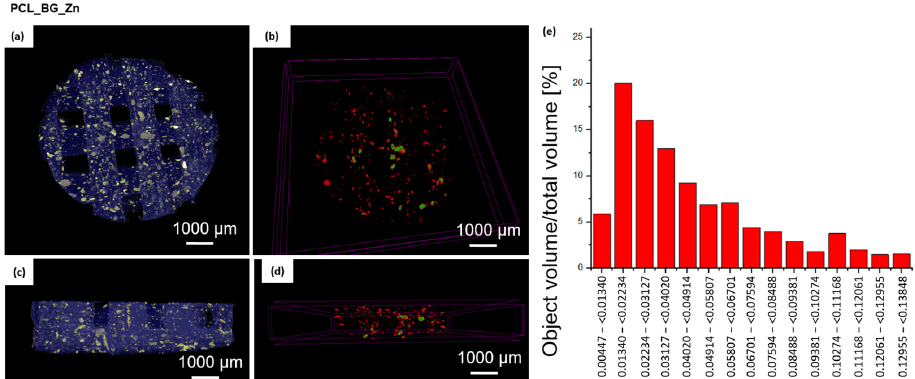
Figure 7. µCT images of sample PCL_BG_Zn before incubation in SBF. Images showing the top view ( a ) and the cross-section of the scaffold ( c ). The scaffold volume is marked in blue; the distribution of the modifying particles is highlighted in yellow. Distribution of BG_Zn particles without the pol- ymer matrix ( b , d ) (particles marked in red and green). Histogram of the distribution of particles ( e ). In the sample PCL_BG_Zn before incubation (Figure 7), 1596 inclusions were de- tected, which was 0.4% of the scaffold volume. The average thickness of inclusions was 46 µm, and about 20% of inclusions were in the thickness range of 13–22 µm.